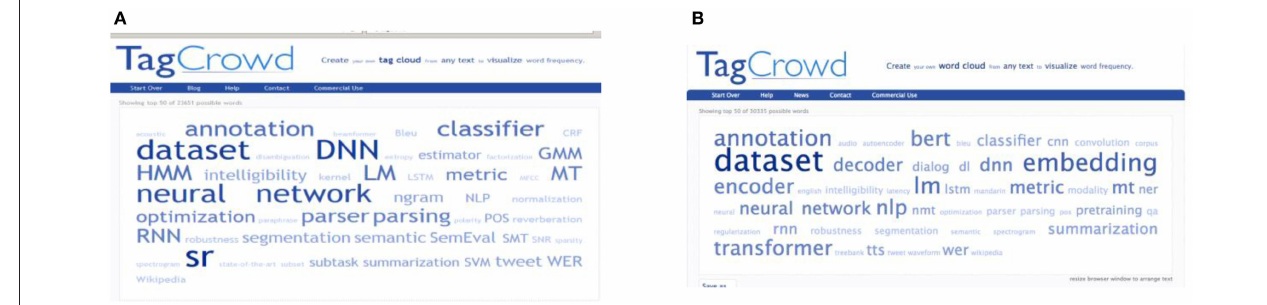
FIGURE 37 | (A) Tag Cloud based on the abstracts of 2015. (B) Tag Cloud based on the abstracts of 2020. TABLE 22 | Research topic prediction based on term frequency using the selected Weka algorithm. Rank